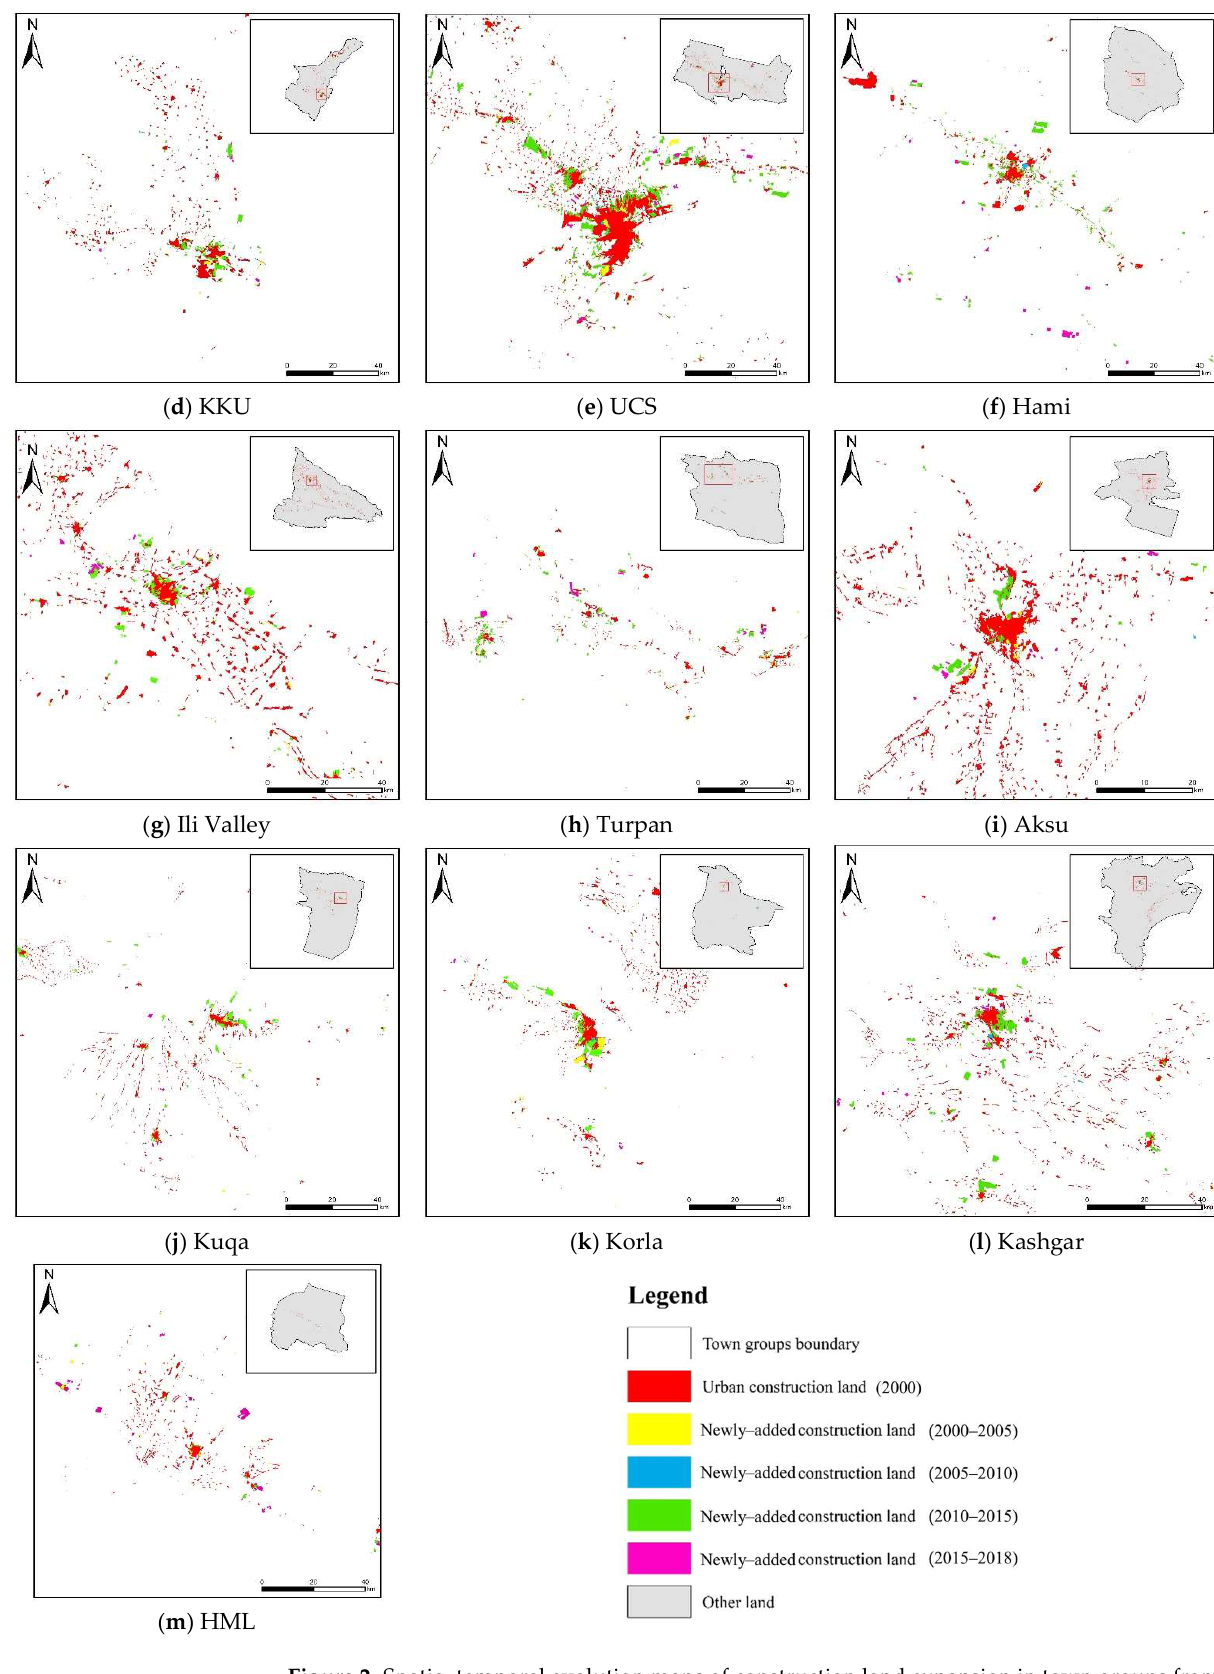
Figure 2. Spatio–temporal evolution maps of construction land expansion in town groups from 2000 to